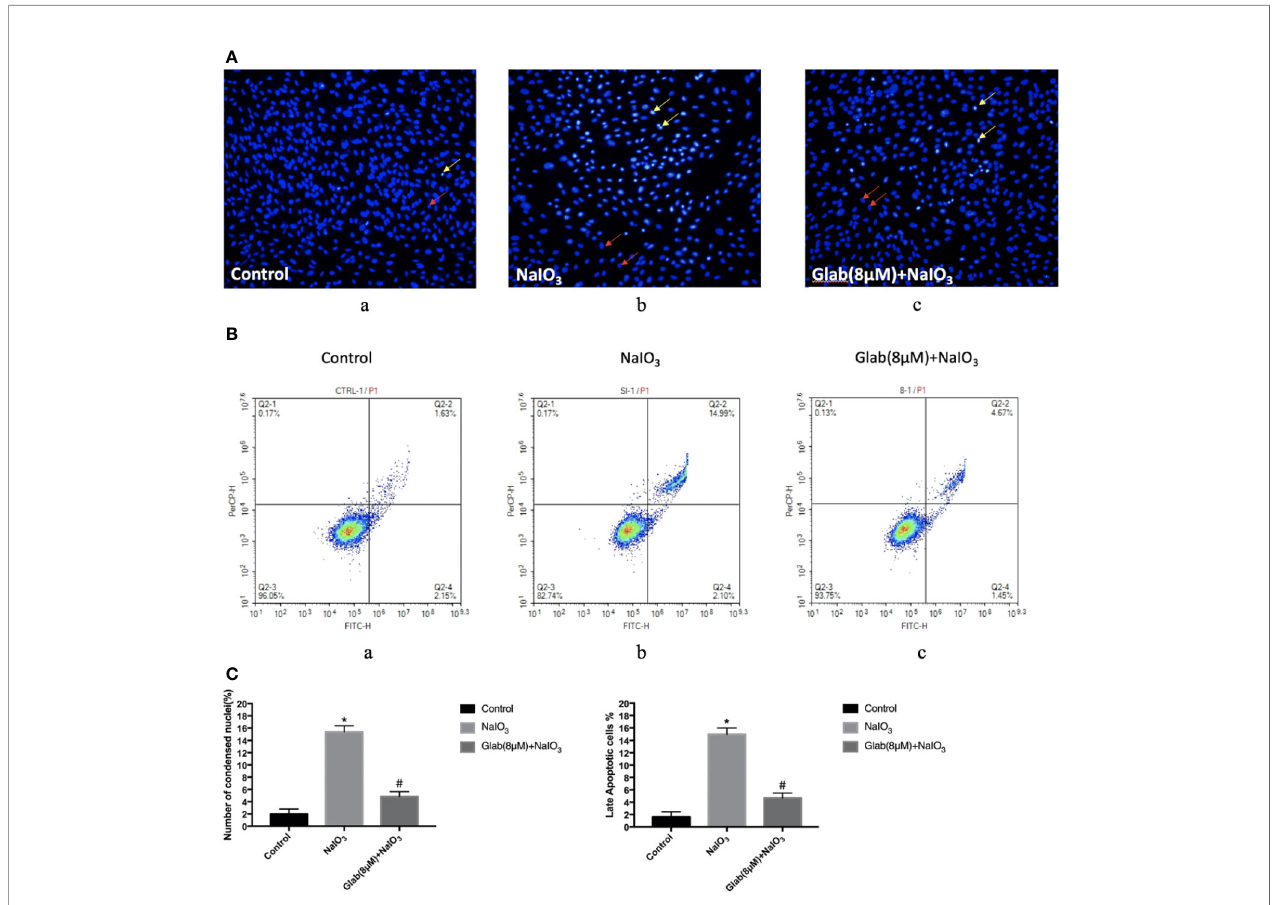
FIGURE 2 | Effects of Glabridin on apoptosis of ARPE ‐ 19 cells in vitro . (A) Hochest 33342 staining of ARPE ‐ 19 cells treated with sodium iodate for 24 h. Yellow arrows indicate condensed core vs. Red arrows indicate normal core. a, retinal pigment epithelium (RPE) treated with DME-F12 (Control); b, RPE treated with sodium iodate(1200 m g/ml) (NaIO 3) ; c, RPE treated with Glabridin(8 m M) plus NaIO 3 (Glab(8 m M)+ NaIO 3 ). (B) Flow cytometry analysis of apoptosis of ARPE ‐ 19 cells treated with